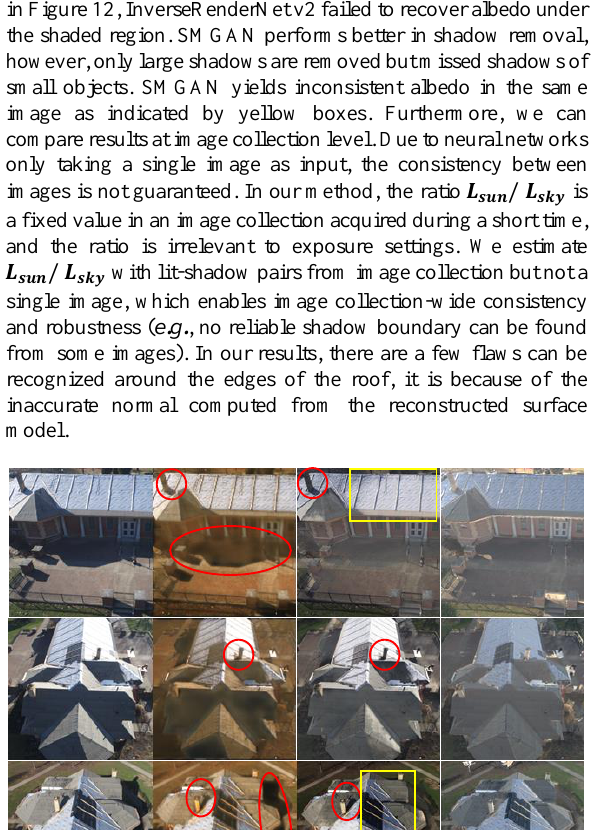
Figure 10. Our albedo and shading estimation.